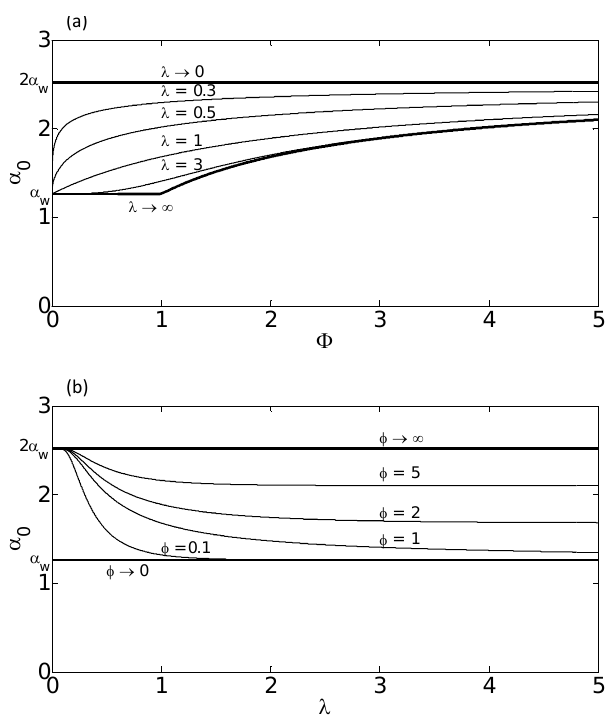
Figure 5. Variation of the Priestley–Taylor coefficient α 0 (Eq. 22 with b = 1 and α w = 1 . 26): (a) as a function of the aridity index (cid:56) for different values of the shape parameter λ of the Turc–Mezentsev function; (b) as a function of λ for different values of the aridity index (cid:56) . The bold lines indicate the limits of the feasible